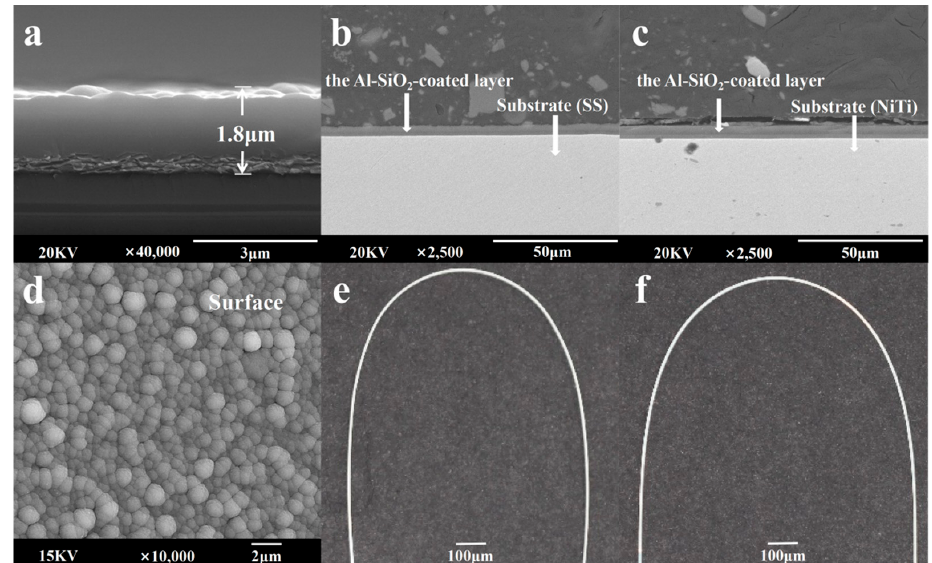
Figure 2. SEM observation of Al–SiO 2 coating and the macroscopic observation of archwire.